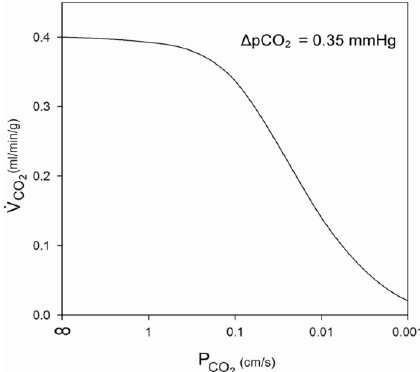
Figure 1. Influence of membrane CO 2 permeability on CO 2 release from a maximally metabolizing cardiomyocyte at a given partial pressure difference of 0.35 mmHg over the half-thickness of the cell. From: Endeward et al. [1].